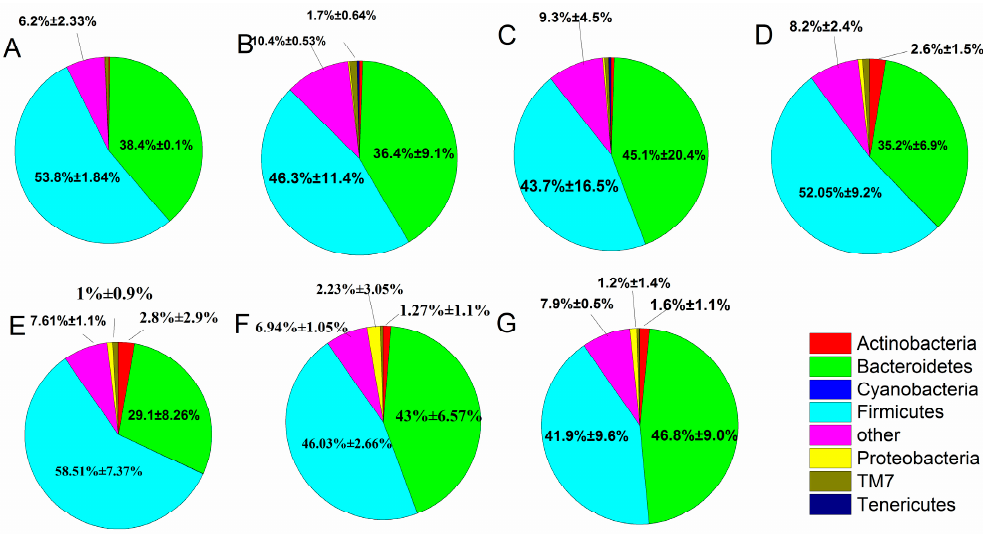
Figure 6. Relative abundance of main phyla in the different groups after constipation: ( A ) normal; ( B ) control; ( C ) phenolphthalein; ( D ) ST-III; ( E ) B. adolescentis CCFM 669; ( F ) B. adolescentis CCFM 667; and ( G ) B. adolescentis CCFM 626.